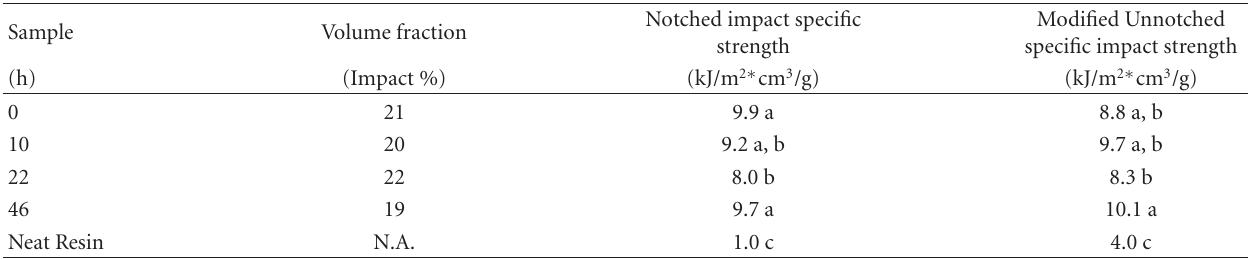
Table 5: Notched and unnotched impact strengths of enzyme-retted flax fiber composites ∗ .